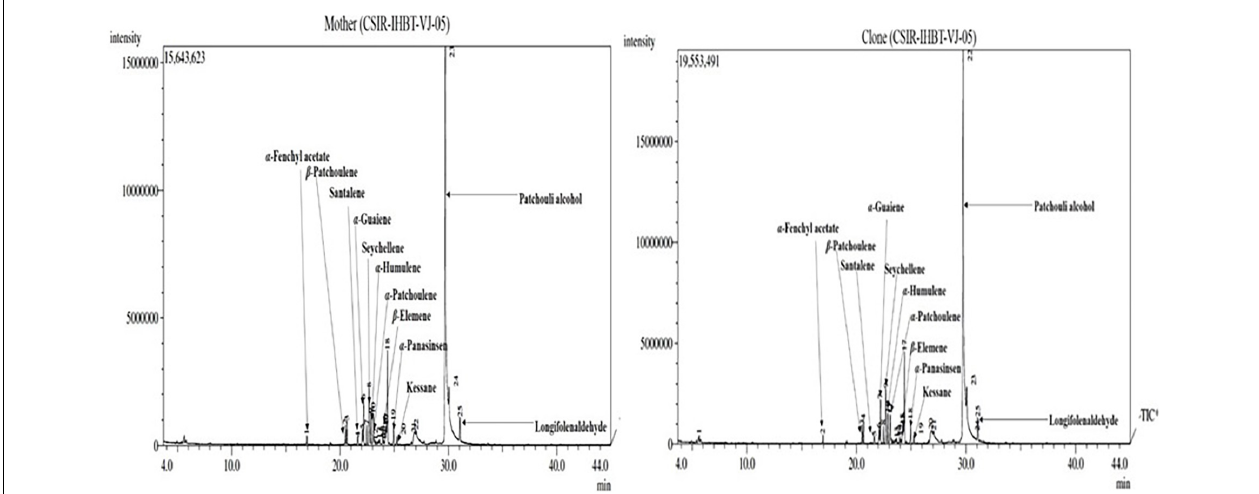
FIGURE 5 | Chromatograms of essential oil sample of mother and clonal plants of CSIR-IHBT-VJ-05.